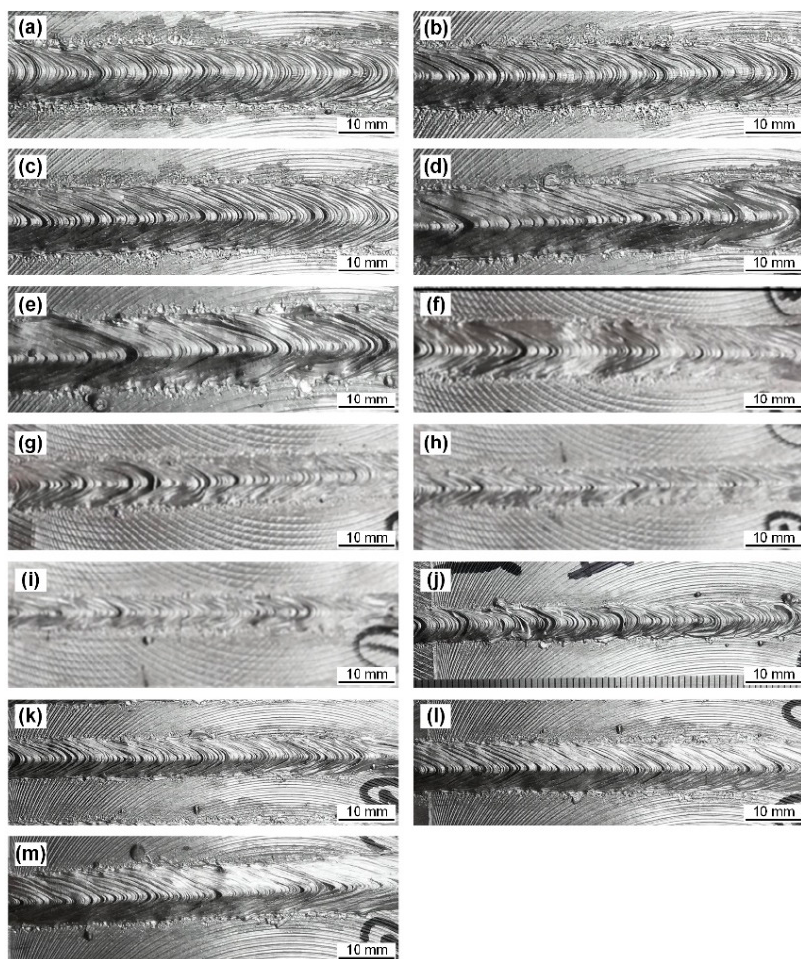
Figure 5. Weld surface morphologies; ( a – e ) laser power at 3, 3.5, 4, 4.5 and 5 kW under given welding speed of 1.8 m/min and welding current of 100 A, ( f – i ) welding speed at 1.2, 1.5, 2.1 and 2.4 m/min under given laser power of 4 kW and welding current of 100 A and ( j – m ) welding current at 50, 75, 125 and 150 A under given laser power of 4 kW and welding speed of 1.8 m/min.